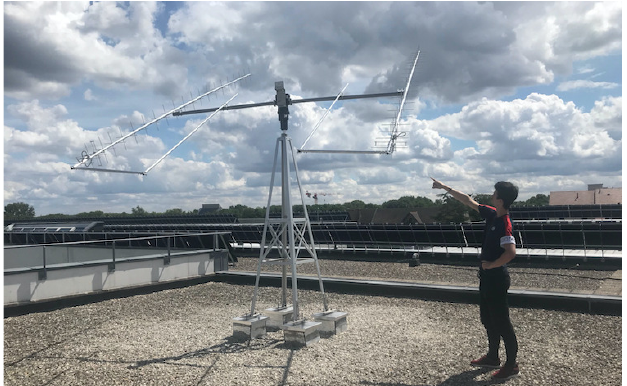
Figure 5. UVSQ/LATMOS UHF/VHF station (one of the stations of the INSPIRE network). LATMOS hosts students from UVSQ and Paris Saclay universities to provide hands-on experience (satellite manufacturing, antenna realization,